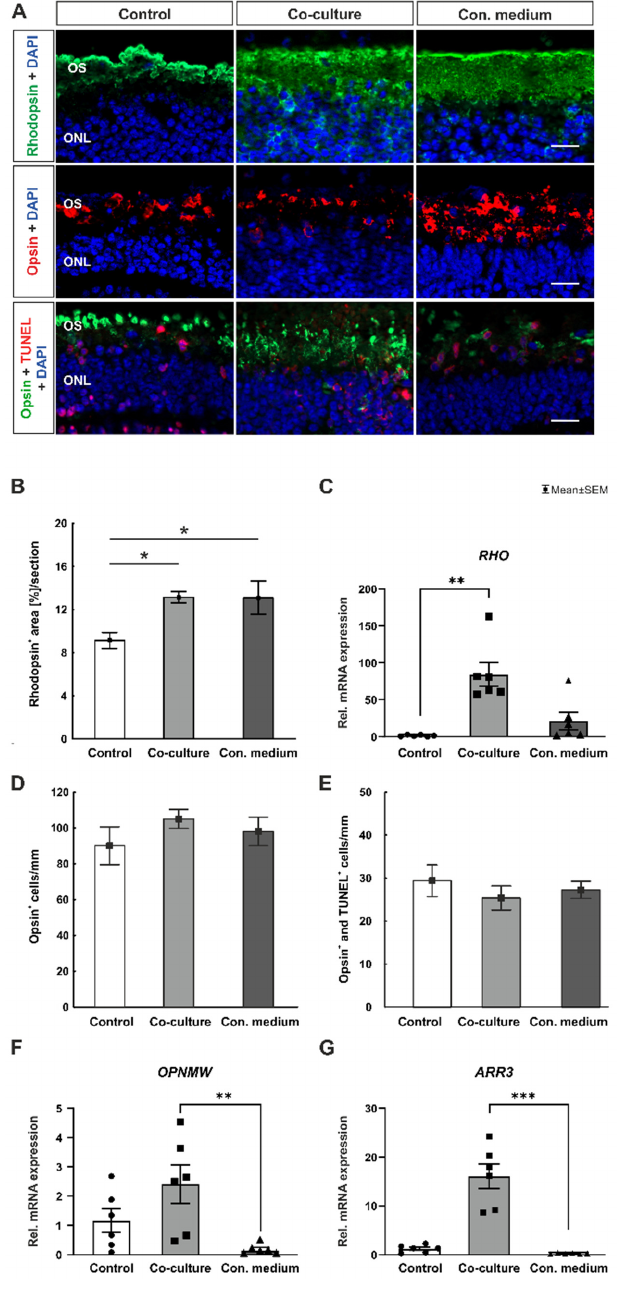
Figure 3. Rods and cones are preserved by co-cultivation with ppRPE. ( A ) Rods were stained with rhodopsin (green), L-cones with opsin (red), and cell nuclei were labeled with DAPI (blue). Additionally, double staining of TUNEL (red) and anti-M/L opsin (green) was performed. ( B ) The rhodopsin + signal area was significantly increased in the co-culture ( p = 0.033) and conditioned medium group ( p = 0.035) compared to controls. ( C ) Relative mRNA expression of RHO was significantly increased in the co-culture group ( p = 0.001) compared to control. ( D ) The amount of opsin + cells was comparable in all three groups. ( E ) The number of Opsin + and TUNEL + was even in all three groups. ( F ) The co-culture group had a significantly higher expression of OPNMW (p = 0.009) compared to the conditioned medium group. ( G ) ARR3 expression was increased in co-culture samples in contrast to conditioned medium samples ( p < 0.001). OS, photoreceptor outer segments; ONL, outer nuclear layer. Scale bar: 20 µ m, values are presented as mean ± SEM, ( A , B , D , E ) n = 8/group, ( C , F , G ) n = 6/group, * p < 0.05, ** p < 0.01, *** p <